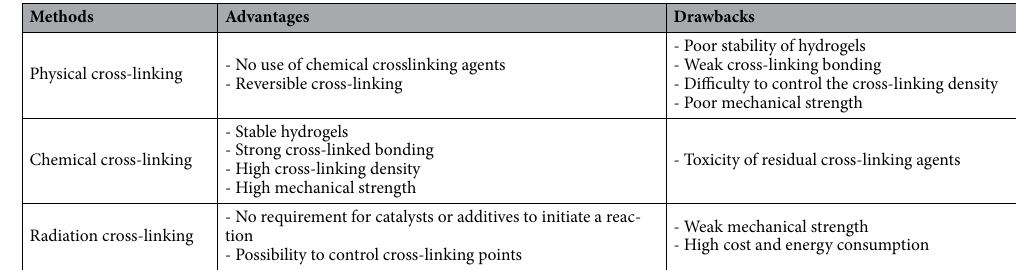
Table 1. Advantages and drawbacks of cross-linking methods to form hydrogels 10–14 .